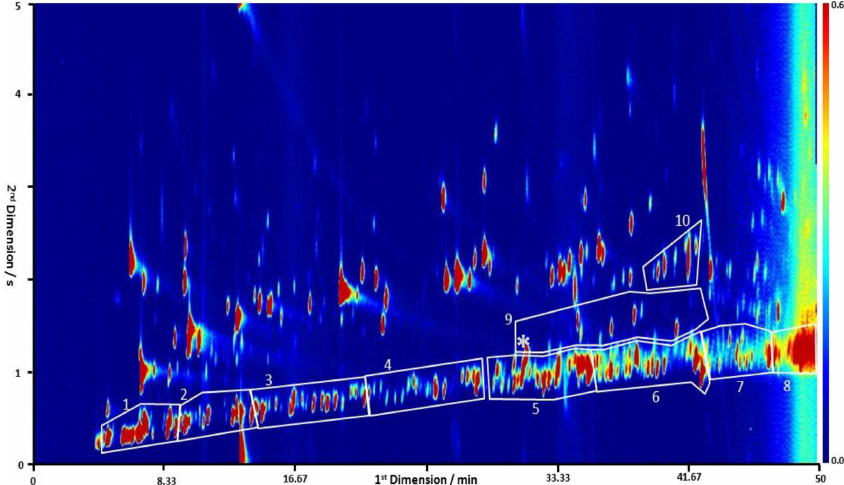
Figure 4. A typical GC GC chromatogram from the summer ClearfLo campaign. The retention times from column 1 (separation based on × volatility) and column 2 (separation based on polarity) are the x and y axis respectively, and compound intensity is the coloured contour. Labelled groups are identified as follows: (1–8) aliphatic groups from C 6 to C 13 , (9) C 10 monoterpenes with * corresponding to α -pinene which is the start of that group and (10) C 4 substituted